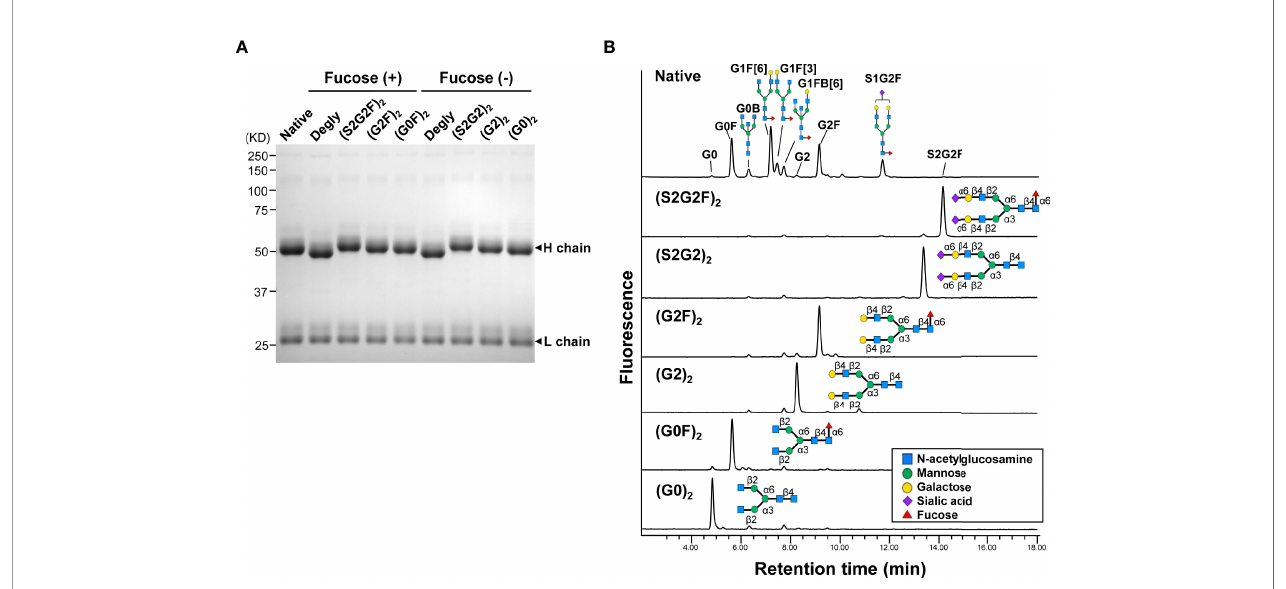
FIGURE 1 | Homogeneous glycoforms of normal polyclonal IgG prepared by chemoenzymatic glycoengineering. (A) SDS-PAGE of the glycoforms of IgG. All the IgG glycoforms including the native protein used in this study were puri fi ed by protein G af fi nity chromatography. (B) HILIC-UPLC analysis of glycans released from the Fc fragments of IgG glycoforms. The peaks of the oligosaccharides of native IgG are listed in Supplementary Table 1